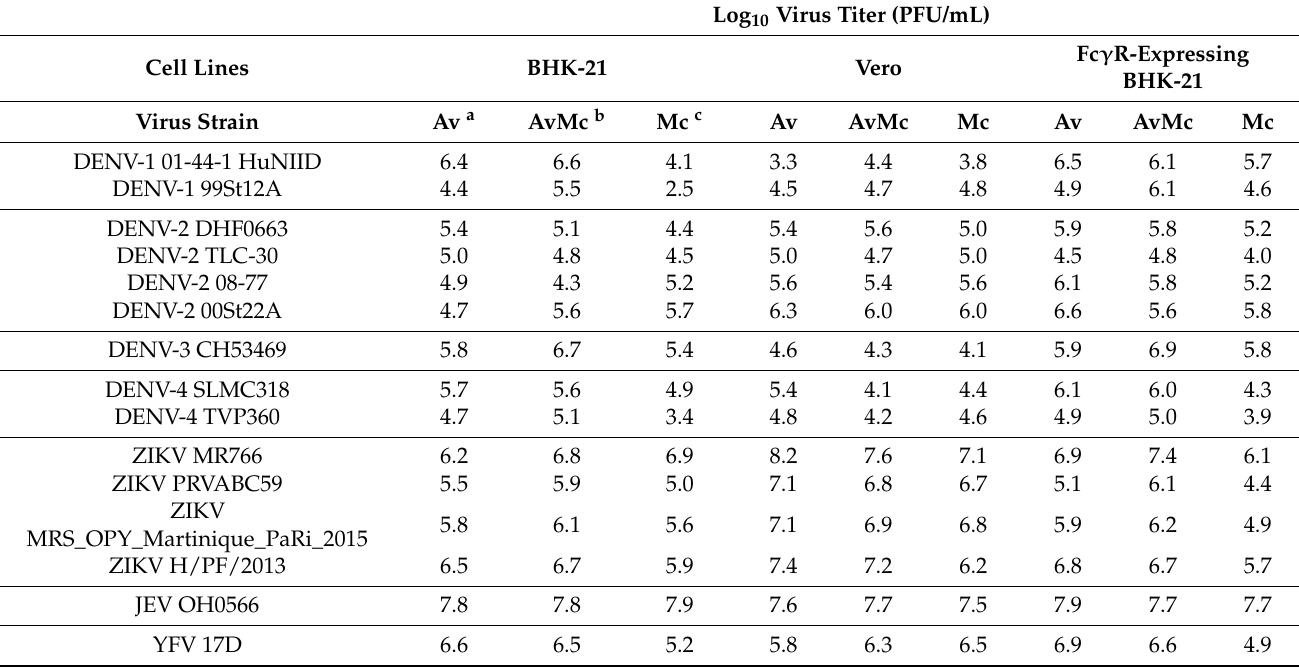
Log 10 Virus Titer (PFU/mL)